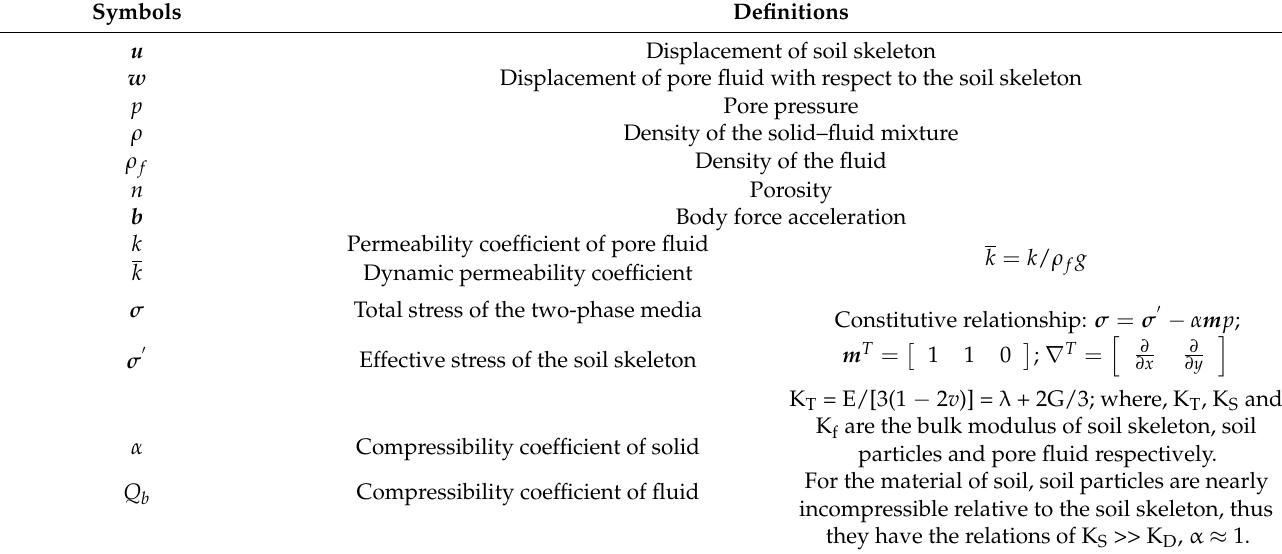
Table 1. Definitions of